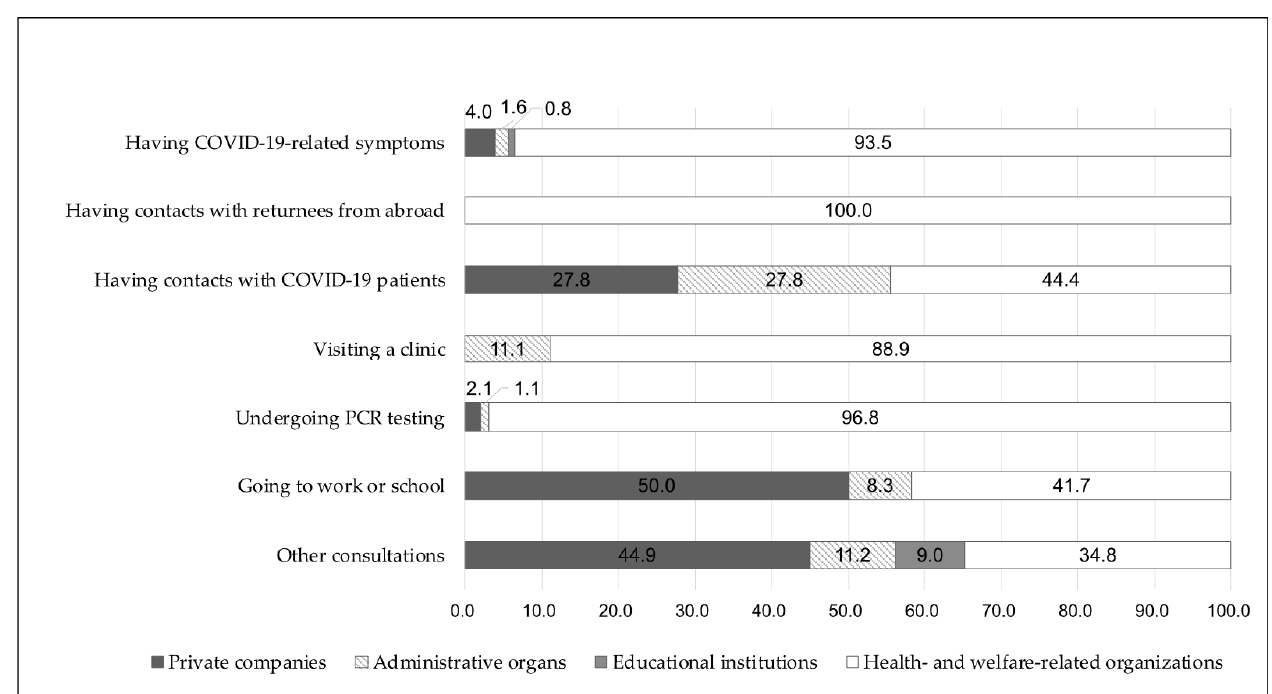
Figure 2. The reasons for calling by the type of organization. Notes: n = 218; PCR: polymerized chain reaction .